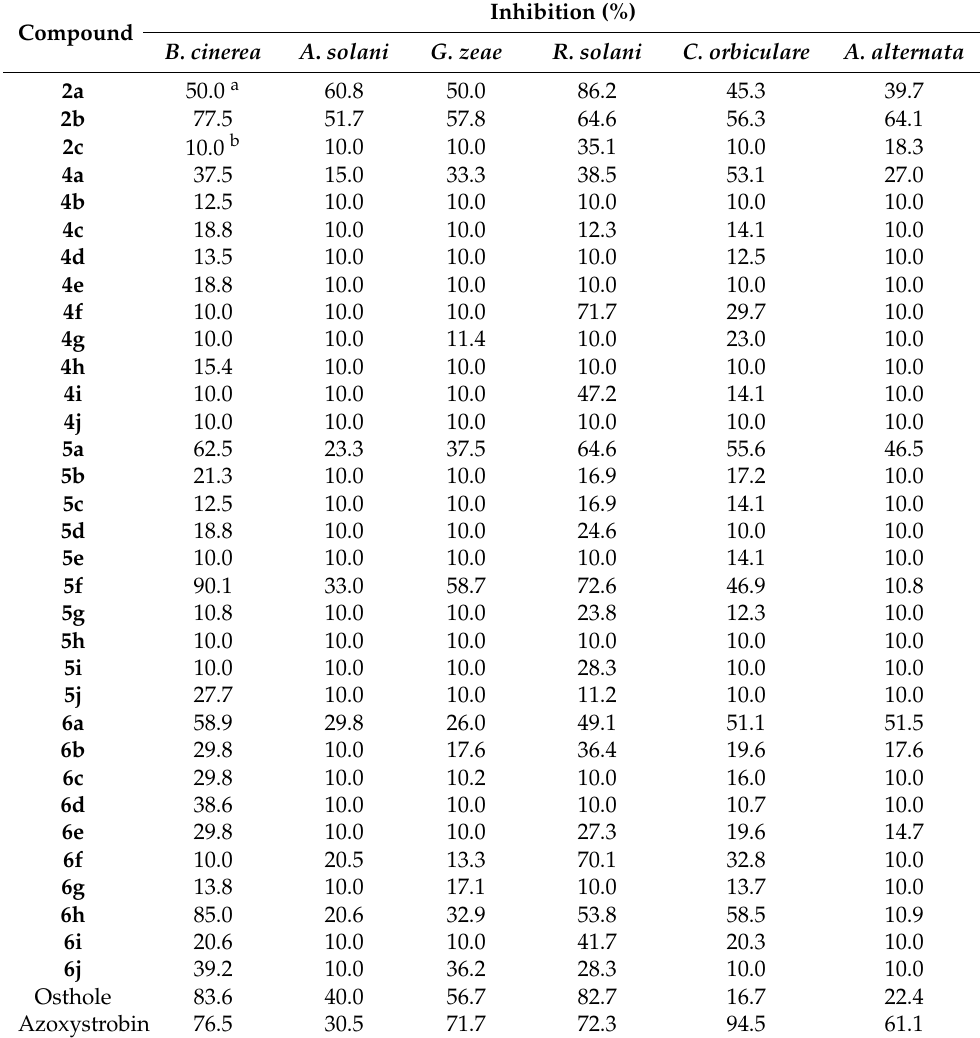
Table 2. Antifungal effects of target compounds at 100 µ